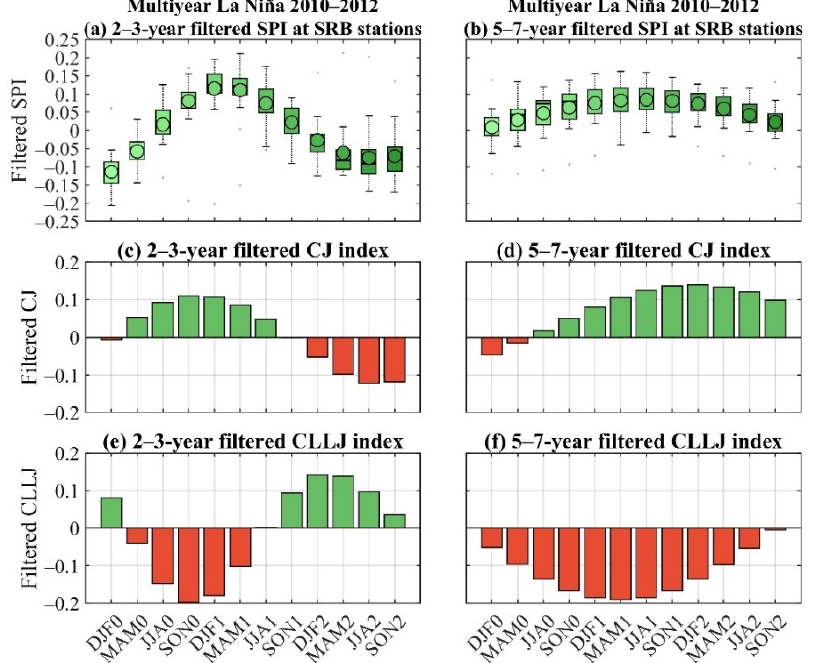
Figure 12. Box plots of the seasonal evolution of the standardized precipitation index (SPI) for the 23 rainfall stations of the Sogamoso River Basin (SRB) filtered at ( a ) quasi-biennial (2–3-year) and ( b ) interannual (5–7-year) scales, as well as seasonal variations of the Chocó jet (CJ) index on ( c ) quasi-biennial and ( d ) interannual scales and of the Caribbean low-level jet on ( e ) quasi-biennial and ( f ) interannual scales during the 2010–2012multiyear La Niña. The display is the same as in Figure 9.